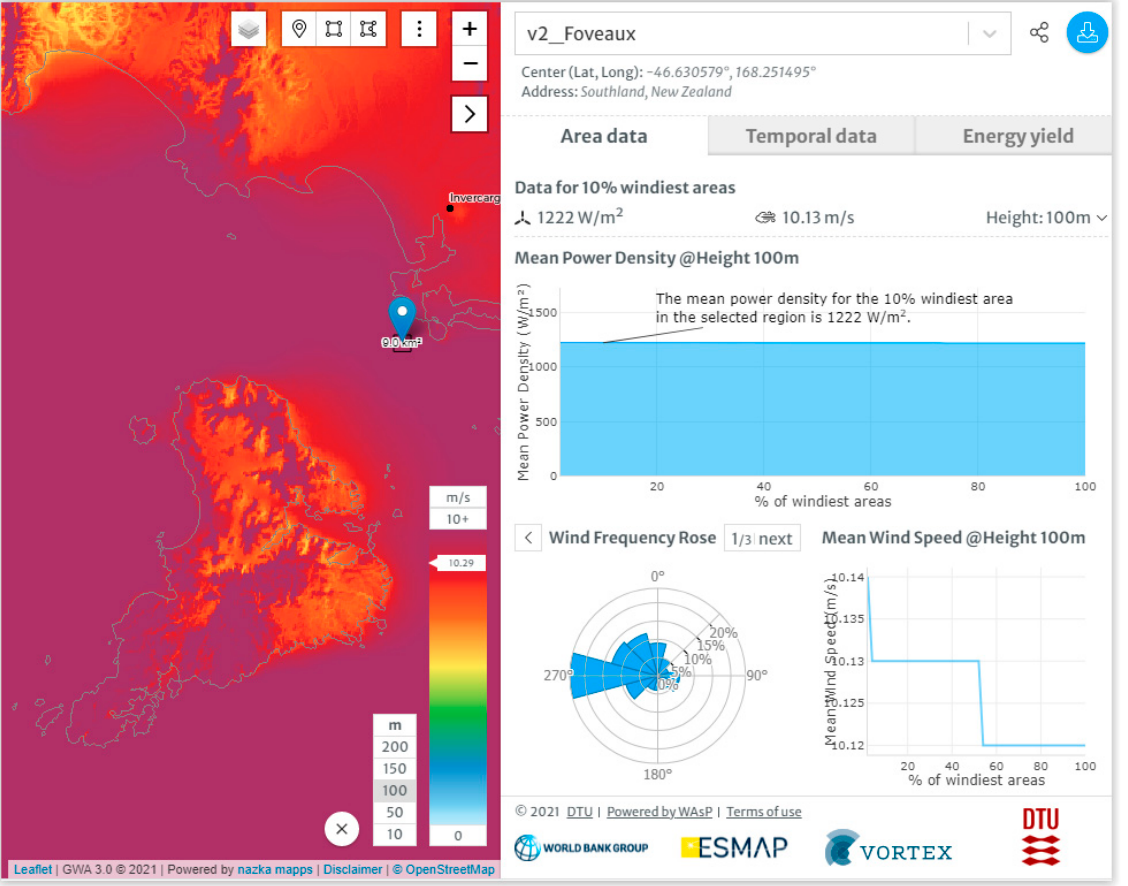
Figure 4. Wind conditions near Stewart Island ( left ) and at the Foveaux site ( right ) [18].